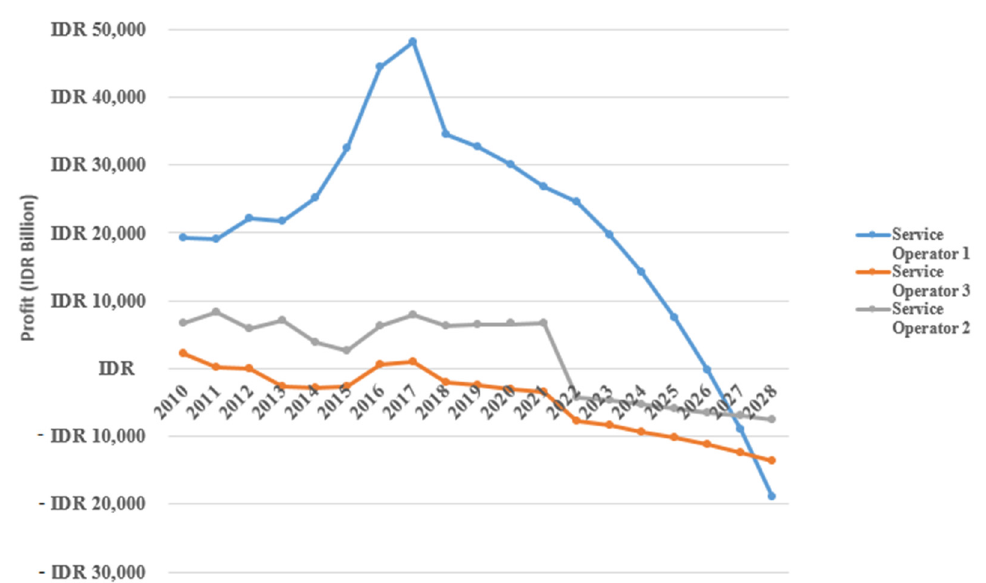
Figure 7 . The trend of the service operators’ profit as a result of 5G implementation in Indonesia